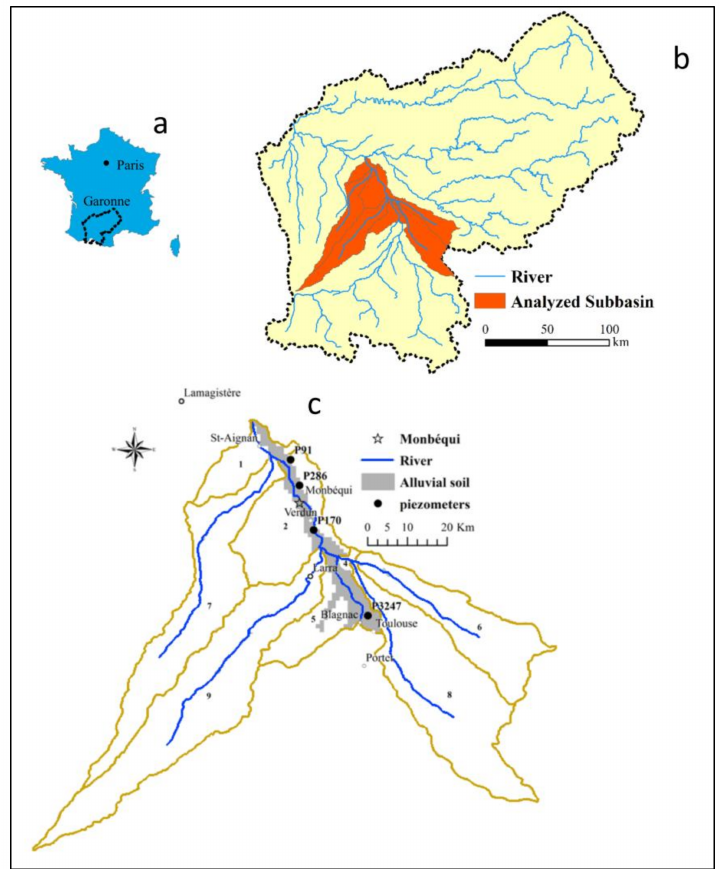
Figure 2. Location of the study site. ( a ) The location of the Garonne River; ( b ) the location of the simulated area; ( c ) the location of the alluvial soil, Monb é qui site, and